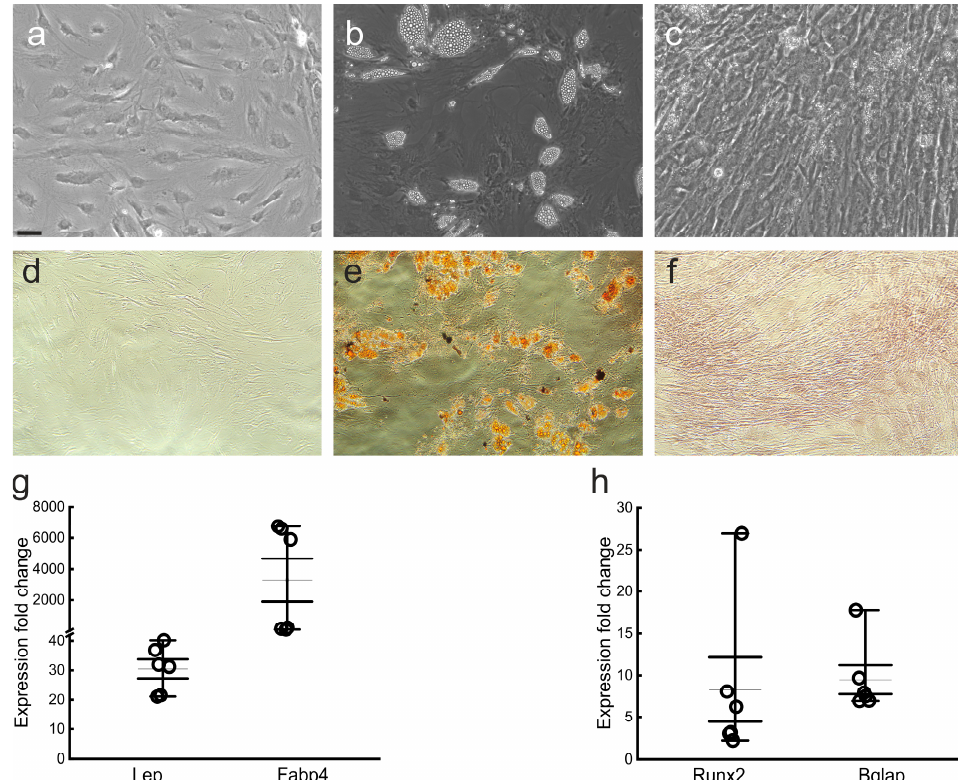
Figure 4. ADSCs isolated using IStemRewind can differentiate into adipocyte and osteocytes. ( a – f ) Representative bright field images of ADSCs isolated using IstemRewind. Cells were cultured in expansion medium ( a , d ) or in adipogenesis ( b , e ) and osteogenesis ( c , f ) inductive conditions. Adipocytes were stained with Oil Red O € and osteocytes were stained using Alzarin Red S ( f ) (magnification: 40×. Scale bar, 100 µm.). ( g ) Box plot of the expression of the adipocyte markers Leptin and FABP4 measured by qRT-PCR in ADSCs after 4 days of adipogenic differentiation. ( h ) Box plot of the expression of the osteocyte markers Osteocalcin and RUNX2 measured by qRT-PCR in ADSCs after 10 days of osteocyte differentiation. Values in g and h represent fold changes over the undifferentiated ADSCs.